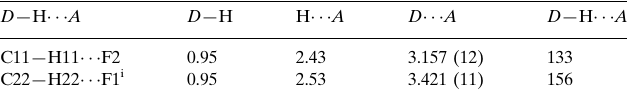
Hydrogen-bond geometry (A˚ , (cid:3)